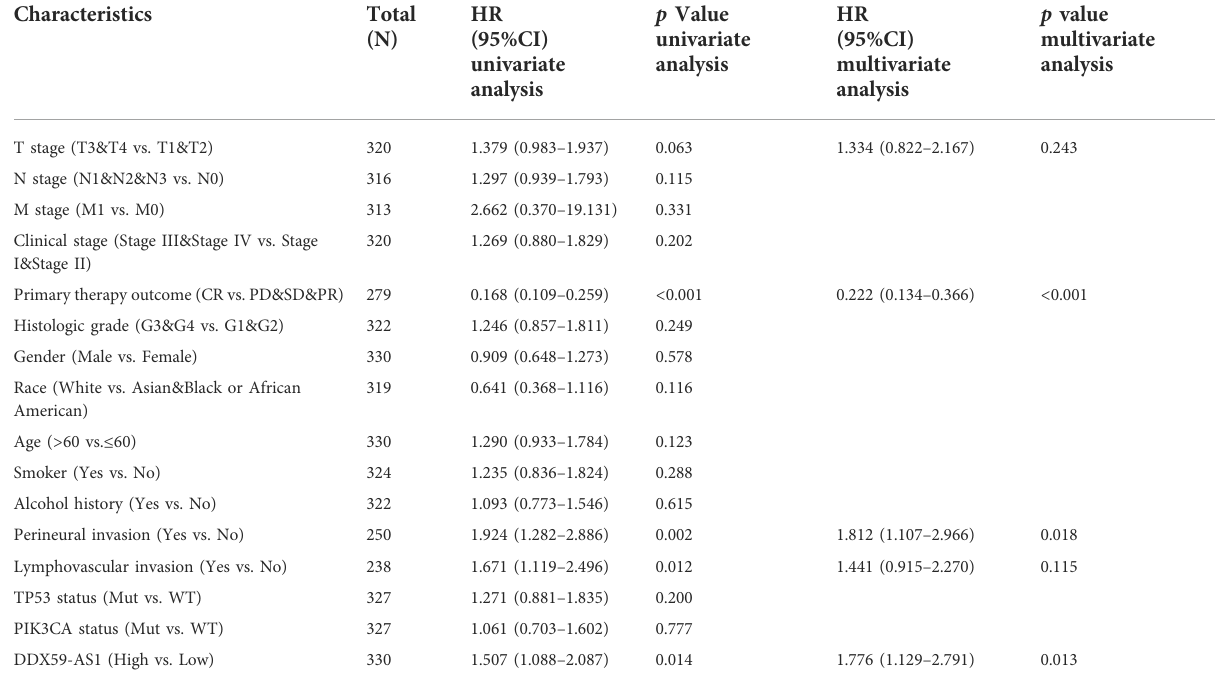
TABLE 3 Cox regression analysis for clinical outcomes in OSCC